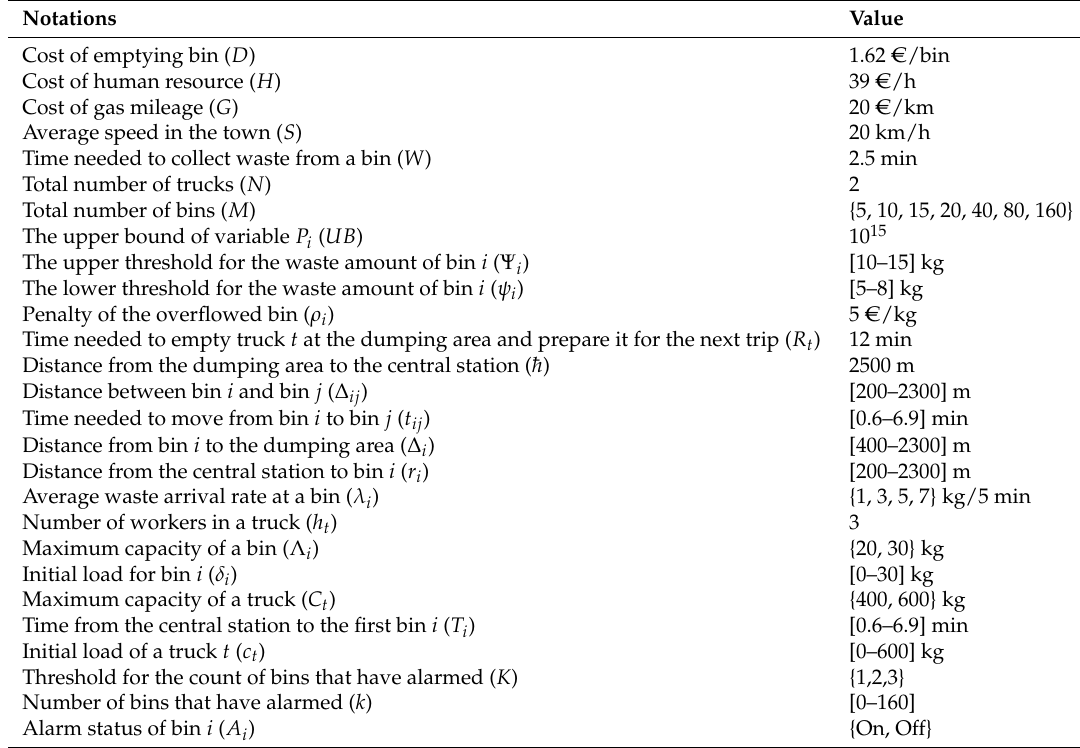
Table 2. Performance evaluation